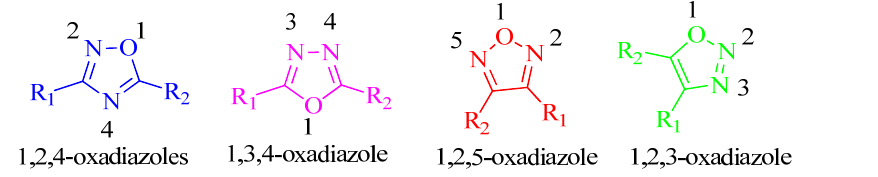
Figure 9. Several regioisomeric forms of oxadiazole rings.